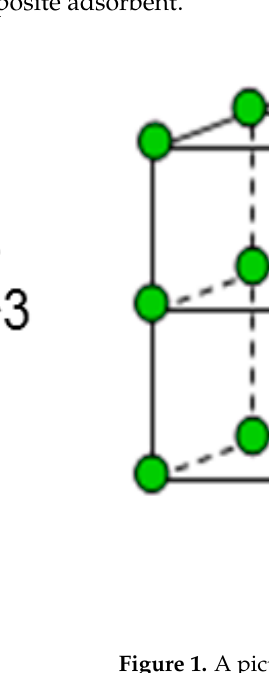
Figure 1. A pictorial view of CCD design.